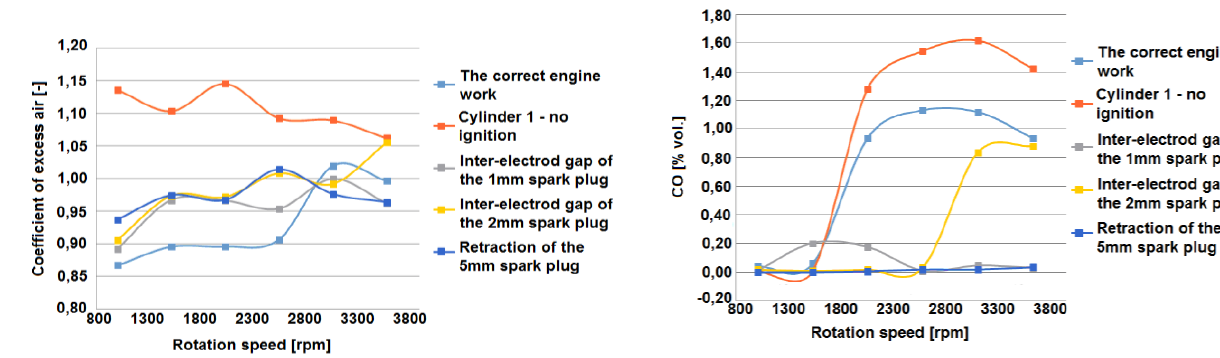
Fig. 19. The content of carbon monoxide in the exhaust gas of the Fiat 1.1 engine